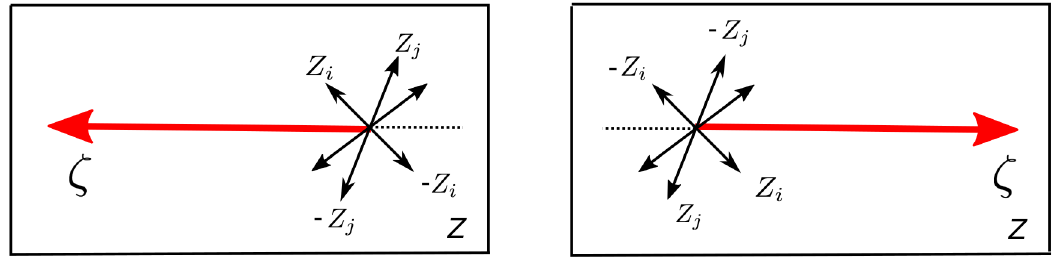
Figure 4 . Two possible choices of conventions for framed BPS quivers such that walls of the second kind, anti-walls and walls of marginal stability for framed BPS states coincide. Notice that they are CPT